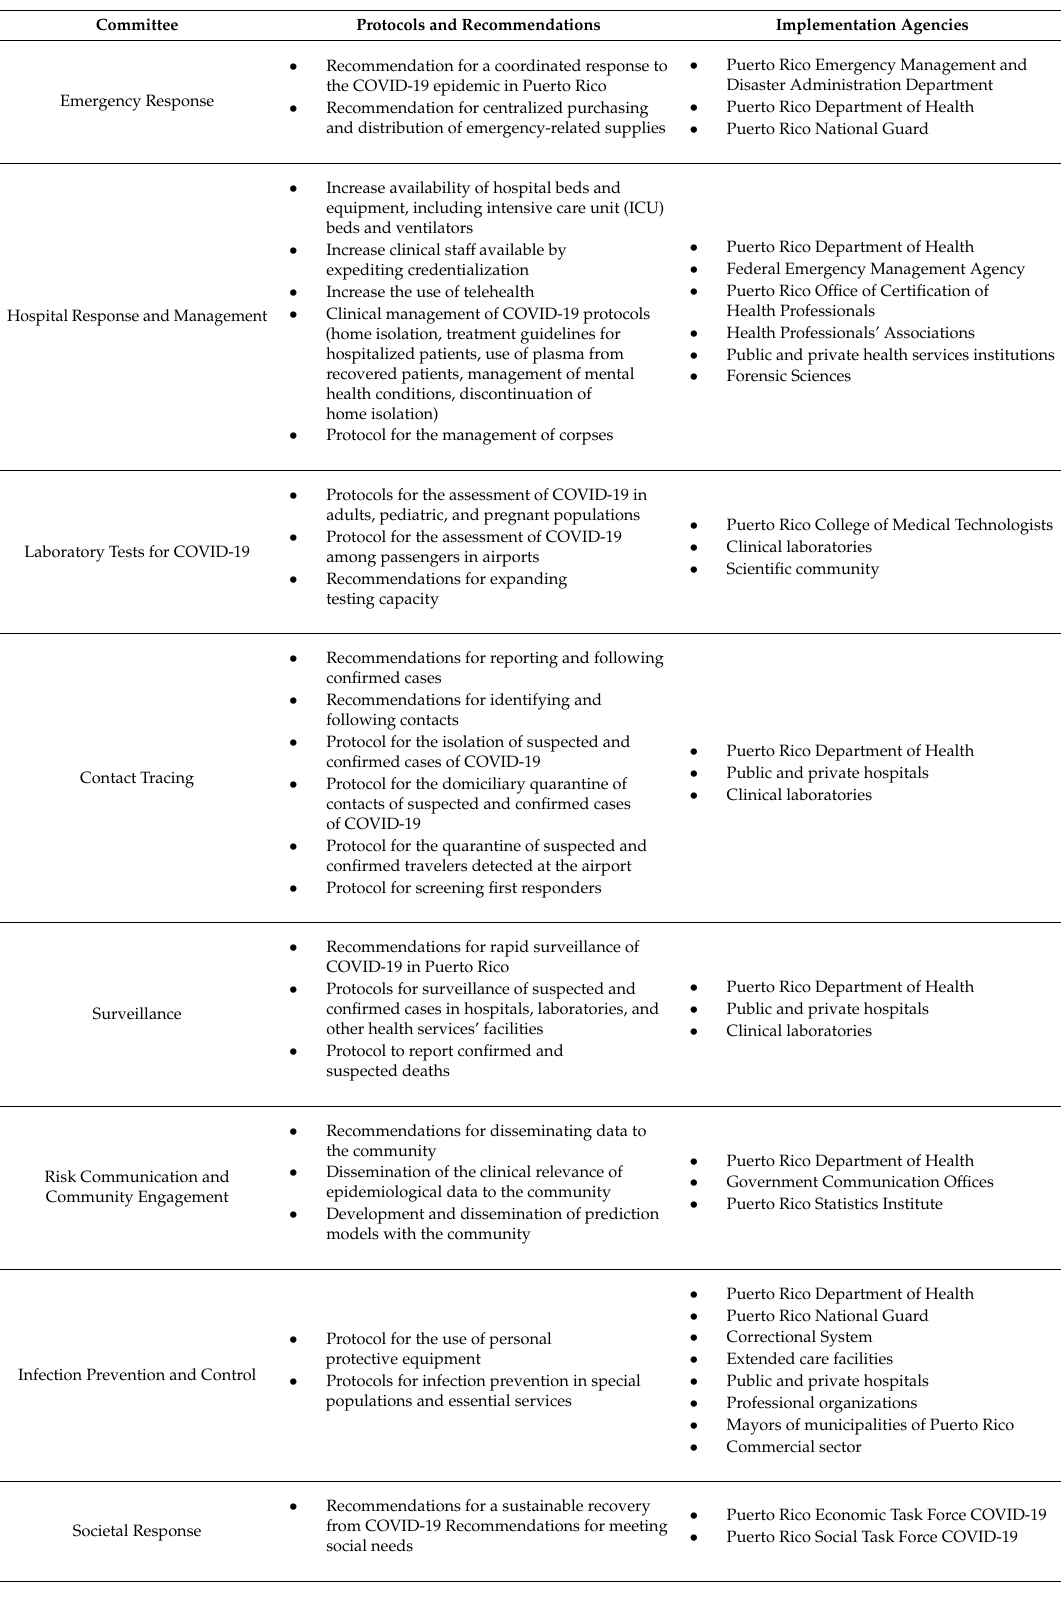
Table 1. Puerto Rico Medical Task Force (MTF) COVID-19 working group committees, protocols created, and a ffi liated implementation